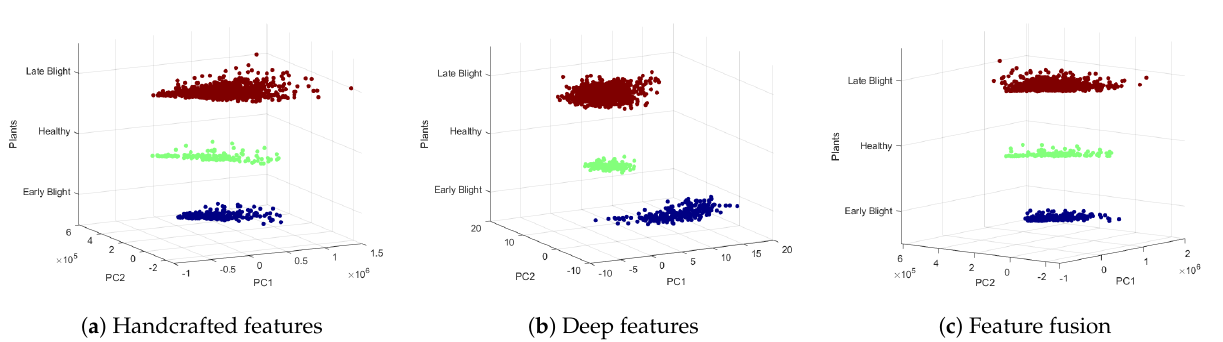
Figure 5. Representation of class discrimination of various feature types by PCs.